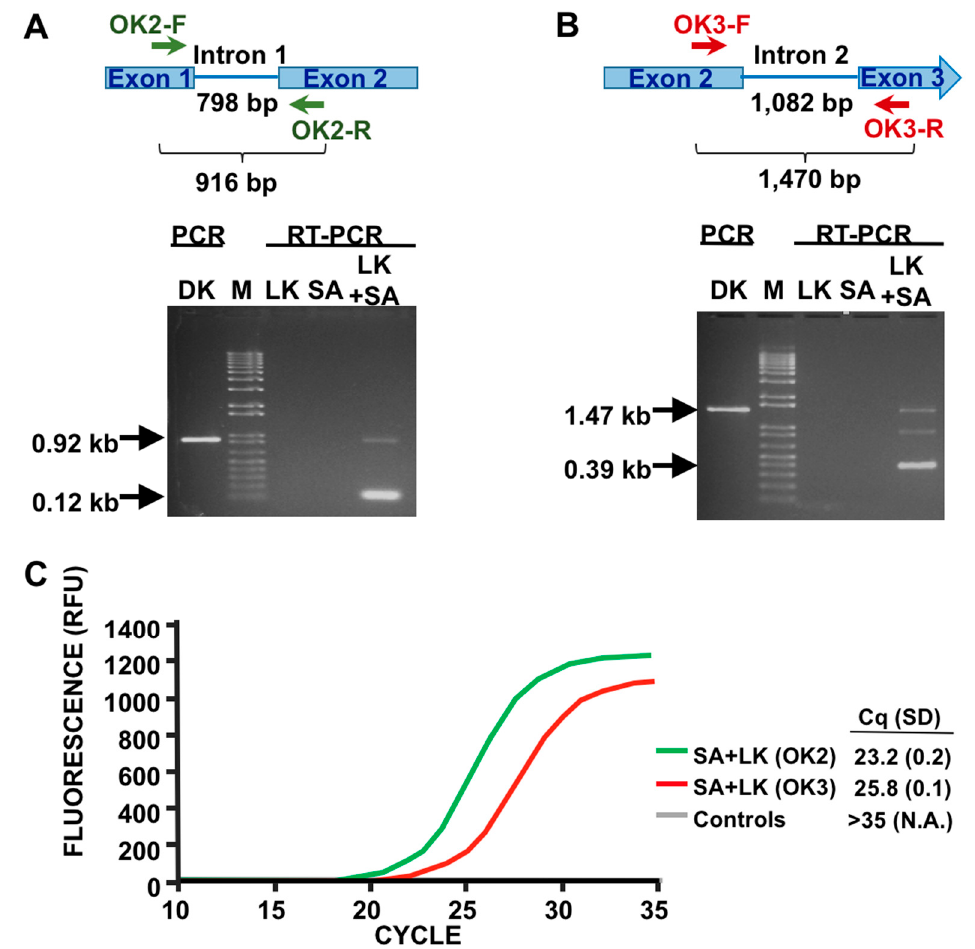
Figure 3. PMMD) with primer pairs OK2 and OK3 and fluorescent qPCR comparison. ( A ) Region and size of phage K gp125 amplified by the primers OK2-F and –R (the size of intron 1 is also indicated); and gel electrophoresis results of PCR from reverse-transcribed phage K lysates (LK), SA cells (SA), and SA cells infected with phage K (SA + LK). PCR from phage K genomic DNA (DK) and a commercial size marker (M) are also shown. The approximate sizes of the major bands are indicated with arrows. ( B ) Region phage K gp125 amplified by the primers OK3-F and -R and gel electrophoresis. Scheme details as in panel (A). ( C ) Fluorescent qPCR of RNA samples amplified with the primer pairs OK2 and OK3. The infections were conducted with diluted SA samples (10 − 4 ) to avoid signal saturation. The colored lines’ correspondence, relative fluorescent units (RFU), number of cycles and Cq average, and S.D. values of three biological replicates performed in parallel are shown. As indicated, the control templates (lysate K, SA cells, and water) did not produce signal either with primer pair OK2 or with OK3.